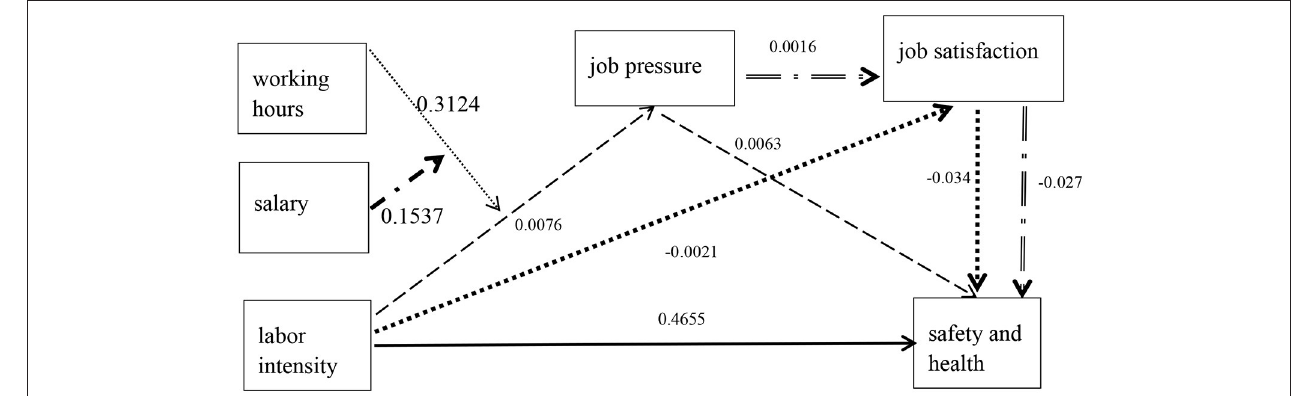
FIGURE 1 | Impact path of the labour intensity on safety and